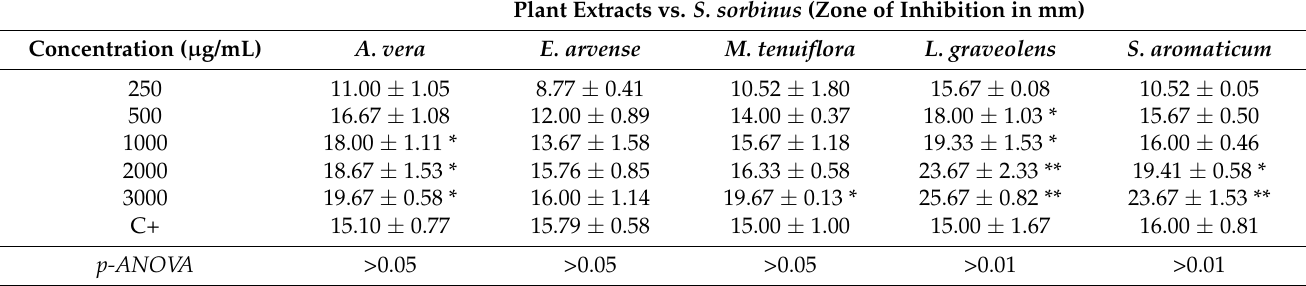
Table 4. Activity of ethanol extracts against S. sorbinus . Plant Extracts vs. S. sorbinus (Zone of Inhibition in